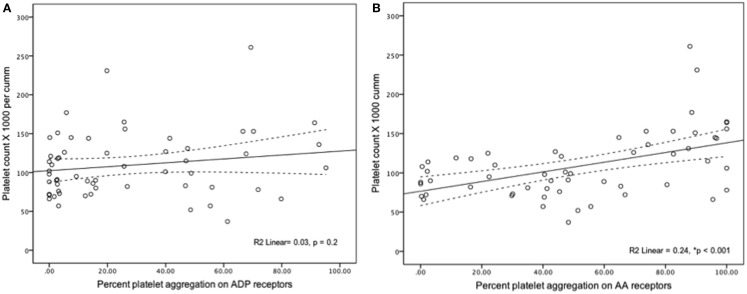
(A,B) Correlation of platelet aggregation and platelet count.